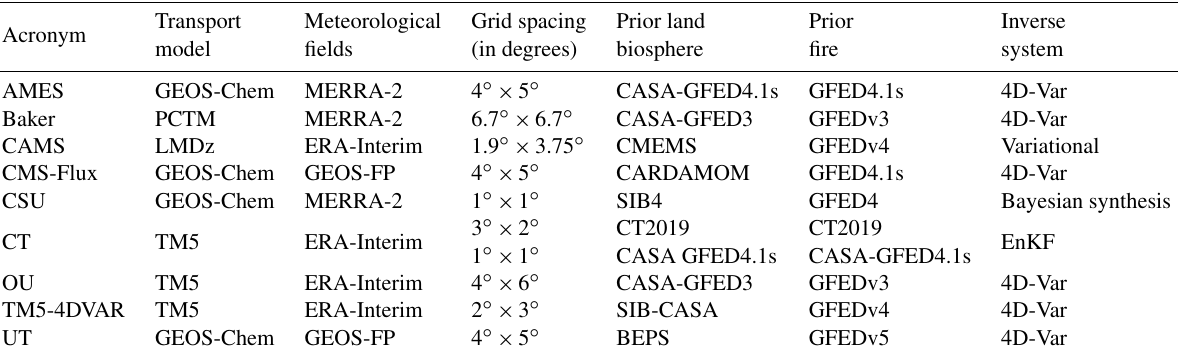
Table 1. Summary of the configuration of the OCO-2 MIP (version 9) design.